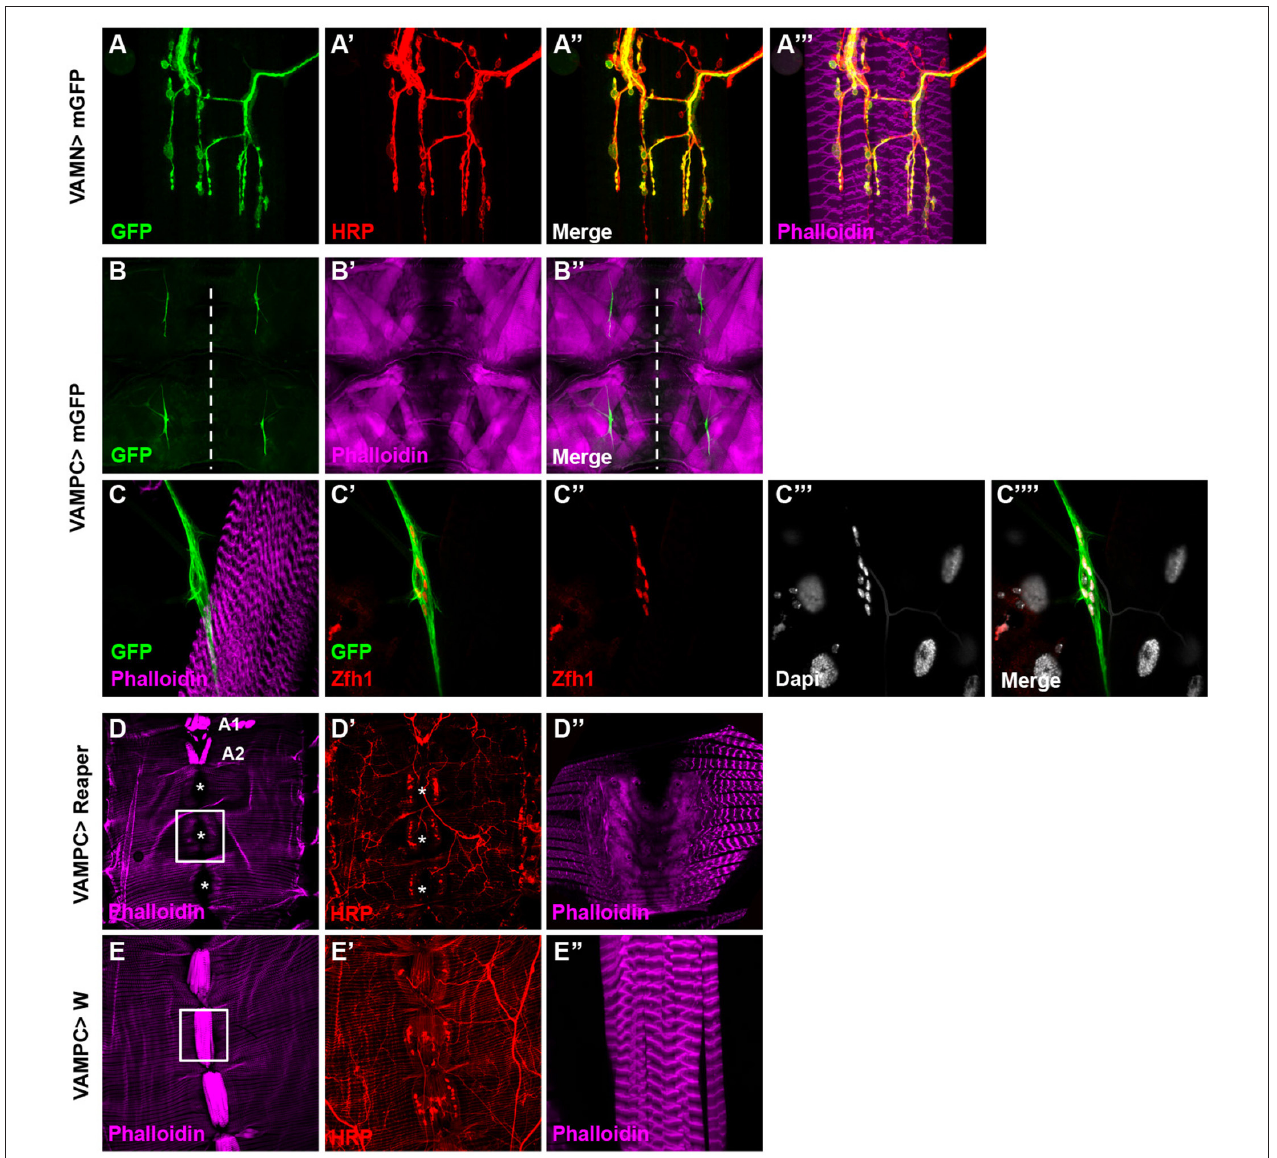
FIGURE 2 | Identification of specific Janelia Gal4 lines related to the VAMs. (A–A”’) The 24G08 Gal4 line allows the expression of the mGFP reporter gene specifically in the MNs (A) innervating the VAMs and was named VAMN Gal4 line (Ventral Abdominal Motor Neurons). One abdominal segment (A3) is presented here with HRP staining (A’) used to label the nervous system. Merged images with HRP (A”) and phalloidin labeling the muscles (A”’) are shown. (B–B”) The 31B08 Gal4 line is expressed specifically in the adult muscle precursors of the VAMs during the third instar larval stage. At low magnification (10X objective), two groups of GFP positive cells are visible per hemi-segment (A3-A4) on each side of the midline (white dashed line in B). Larval muscles (B’) and merged images are shown (B”) in a flat larva preparation. (C-C””) A higher magnification focusing on one group of GFP positive cells (C). These cells express in their nuclei the transcription factor Zfh1 (C’,C”) , an adult muscle precursor marker. Nuclei are Dapi stained ( C”’,C”” ). Muscles are labeled using phalloidin (in magenta). This Gal4 line was named VAMPC (Ventral Abdominal Muscles Precursor Cells). In all presented images the anterior side is up . (D–E”) Apoptosis induced by the expression of reaper with the VAMPC Gal4 line (UAS Reaper/ + ; VAMPC Gal4/ + ) results in adult flies lacking the majority of the abdominal ventral muscles ( D , white asterisks). Only few ventral muscles could subsist (in A1 and A2 segments) compared to control (E) . HRP (in red) stains the nervous system ( D’,E’ ). The white boxes in D and E focus on A4 abdominal segment at higher magnification where the ventral muscles are absent in D” compared to the control condition in E” . Note that in the genetic condition UAS Reaper/ + ; VAMPC Gal4/ + , the lateral muscles are not affected as shown by the phalloidin staining used to label muscles (in magenta). Abdomen is oriented anterior up and posterior